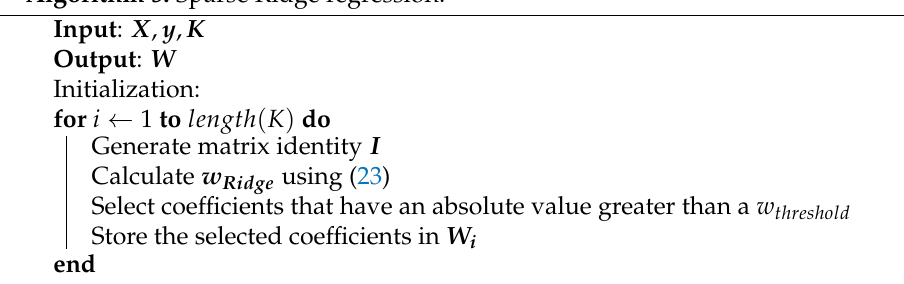
Algorithm 5: Sparse Ridge regression.